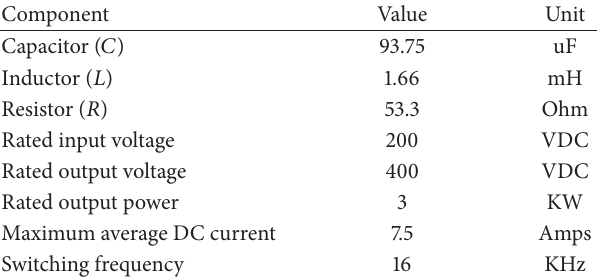
Table 2: Boost converter components